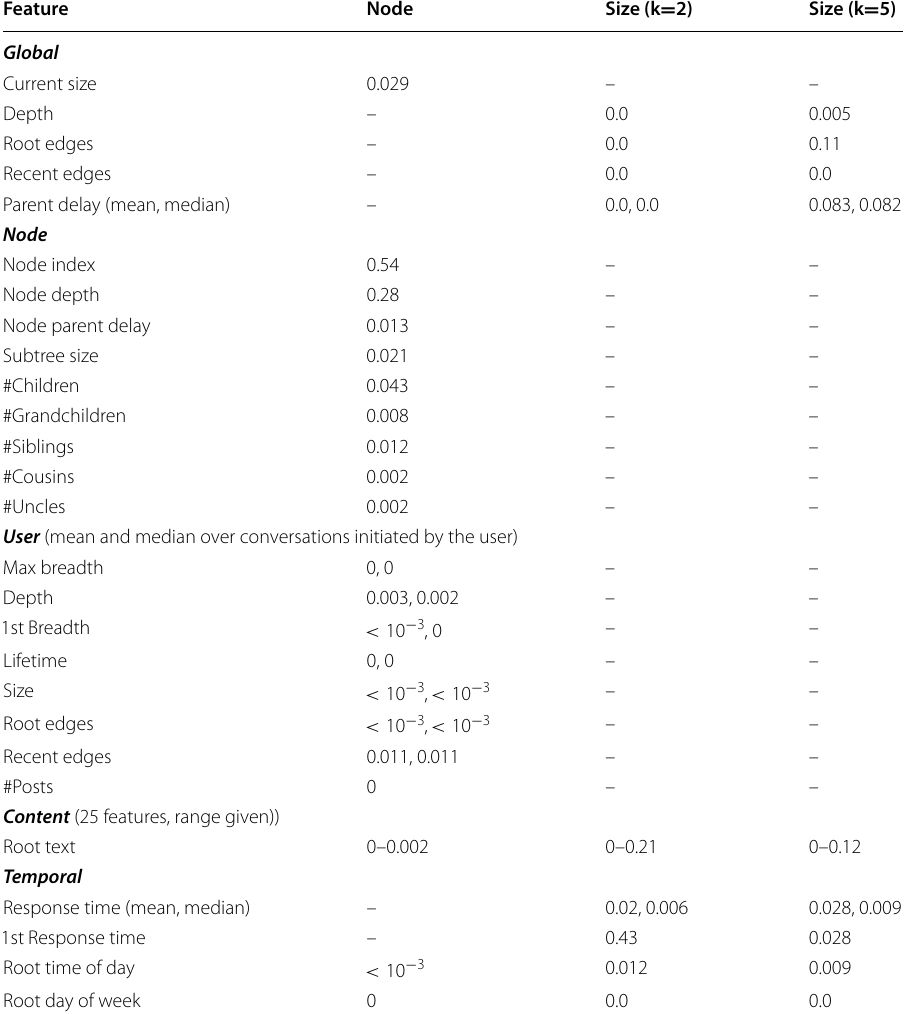
2 and k 5, both for the Twitter CVE dataset = =